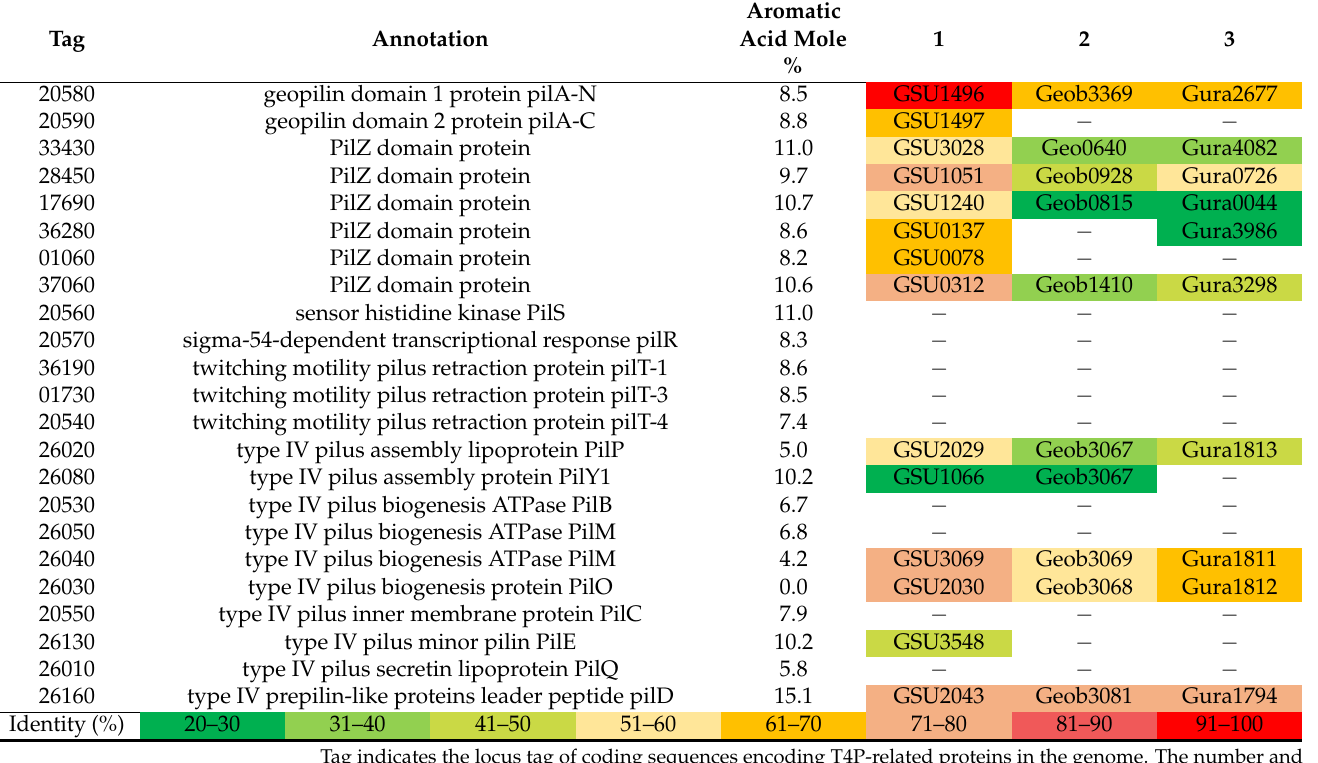
Table 4. List of T4P assembly-related genes in the NIT-SL11